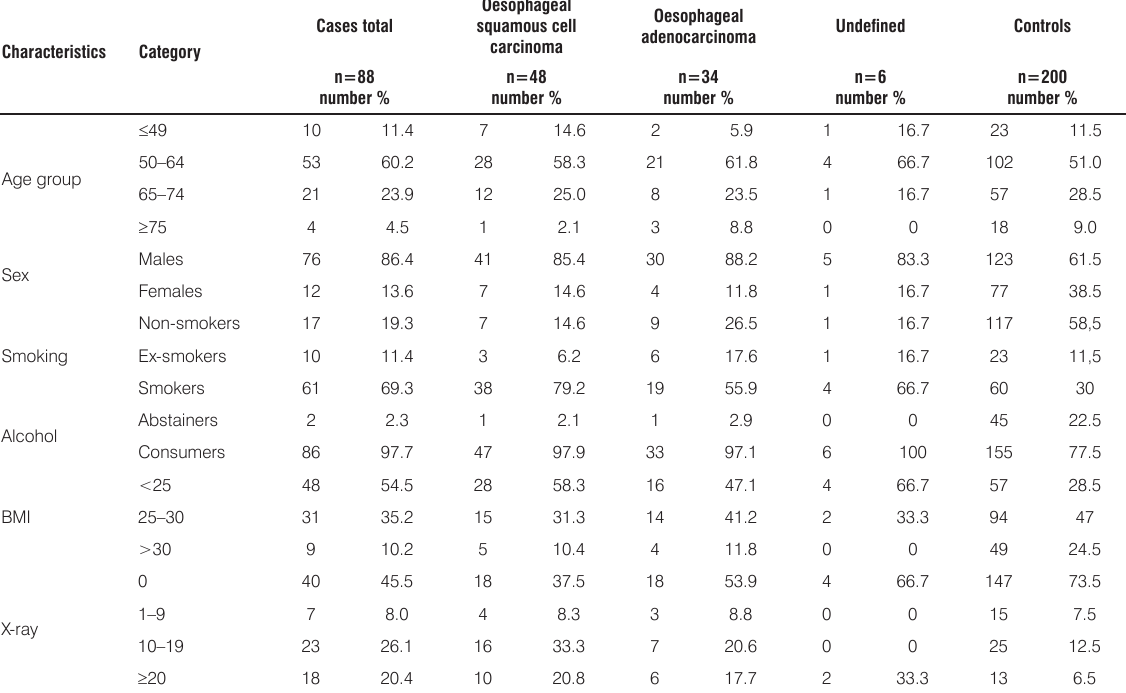
Table 1. Distribution of socio-demographic characteristics and other exposure variables among case and control